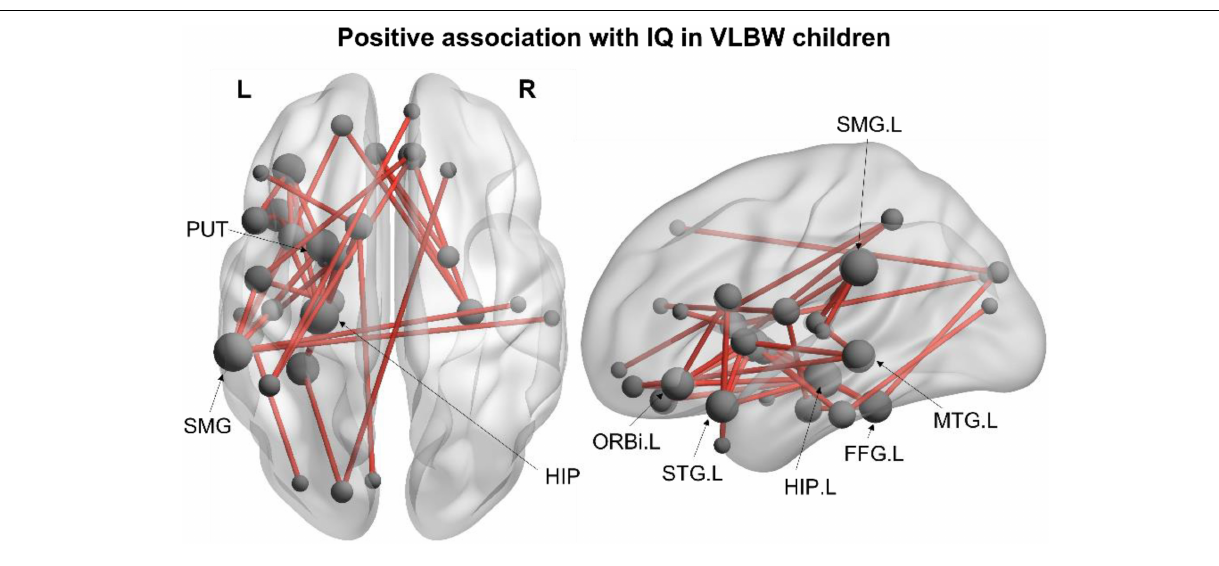
FIGURE 2 | Within-group network analysis. Significant alpha-band (8–14 Hz) network positively associated with IQ in VLBW children (40 edges, 33 nodes, p corr = 0.033). Node size is scaled by